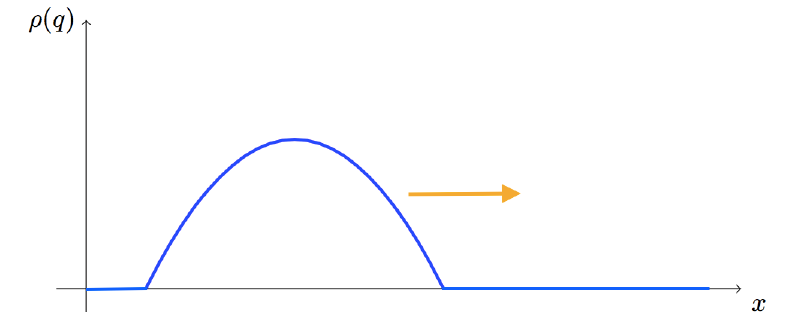
Figure 3. Qualitative illustration of the dynamics of the endogenous institution when cooperators are able to invade. The x axis represents the space while the orange arrow gives the direction of the